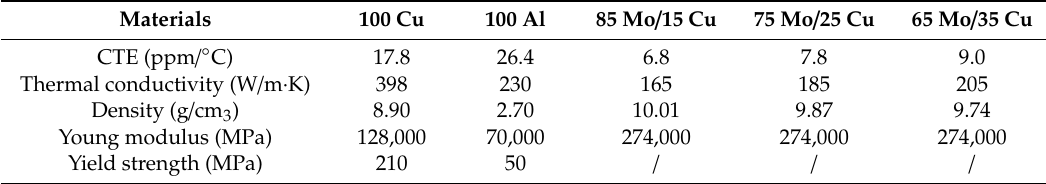
Table 4. The thermal mechanical attributes of materials for the base plate.